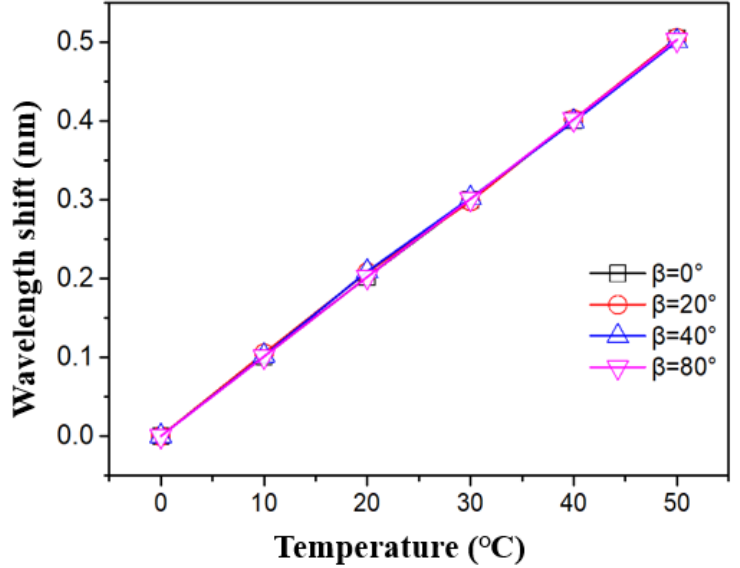
Figure 13. The influence of temperature on a wavelength shift.